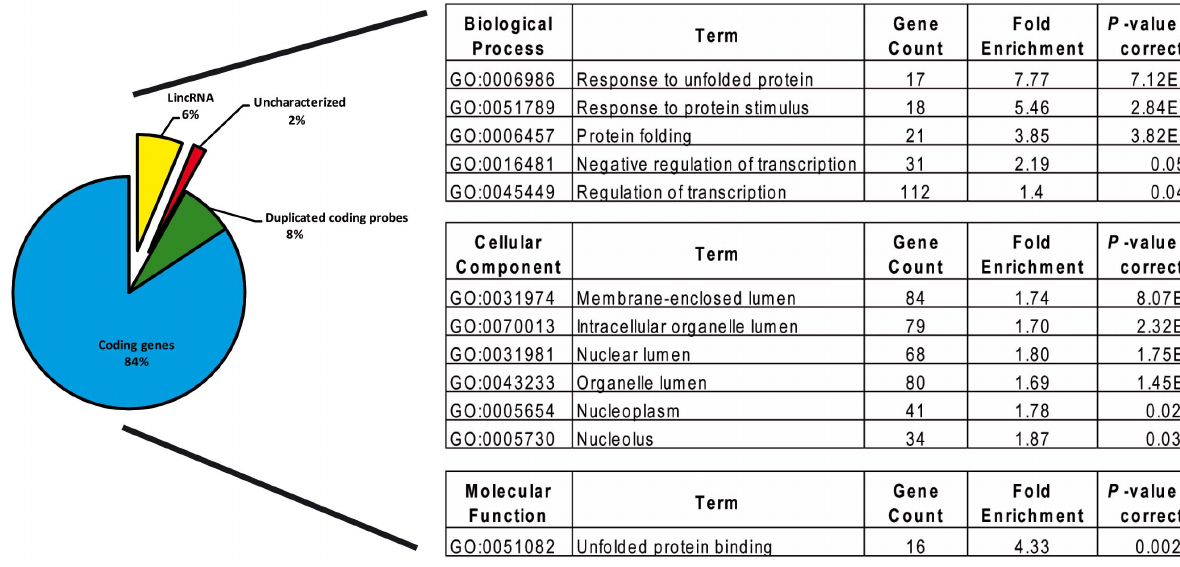
Figure 2. Classification of the 789 differentially expressed probes obtained after the comparison between MMW exposed cells (EXPO) and unexposed cells (Sham). Statistically enrichment of gene ontology (GO) of differentially expressed gene entities was obtained from David gene’s functional annotation.